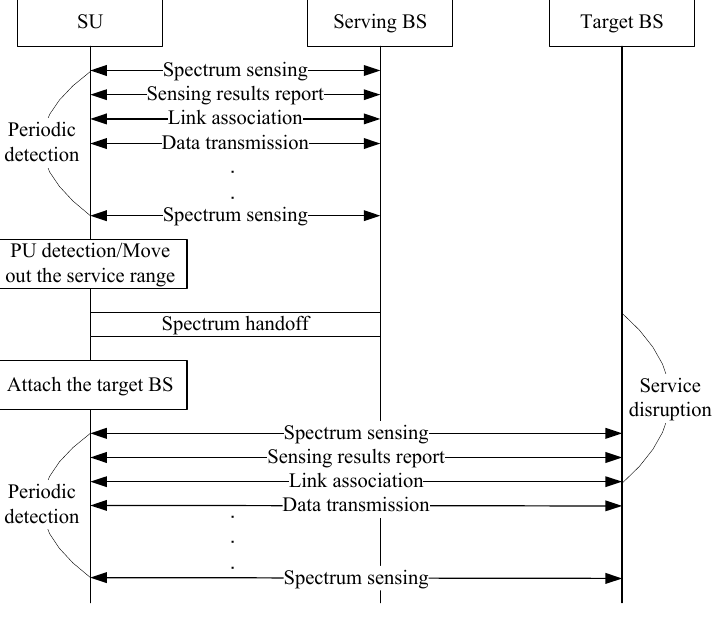
Figure 2. The traditional spectrum handover.